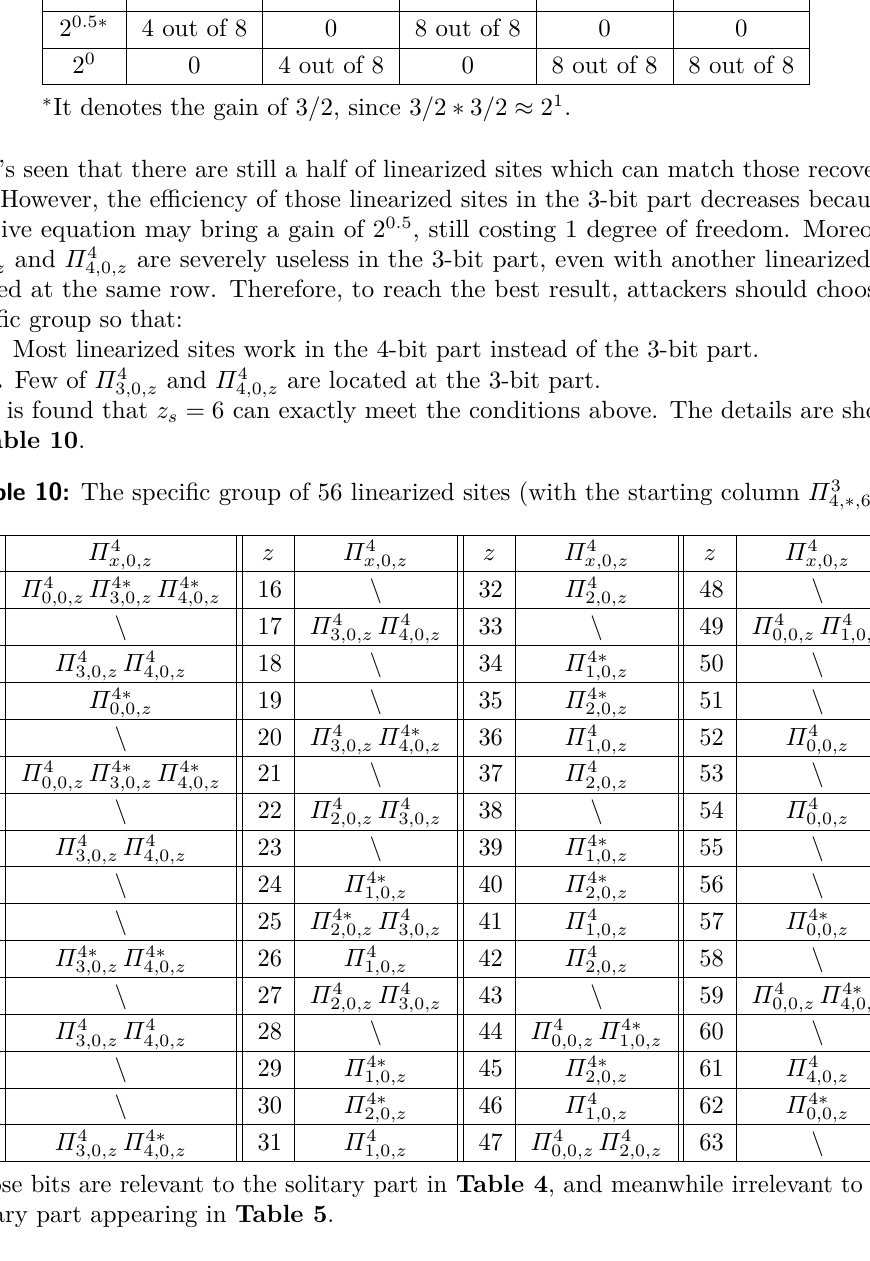
Table 9: Cases of solitary bits matching 3-bit output rows.